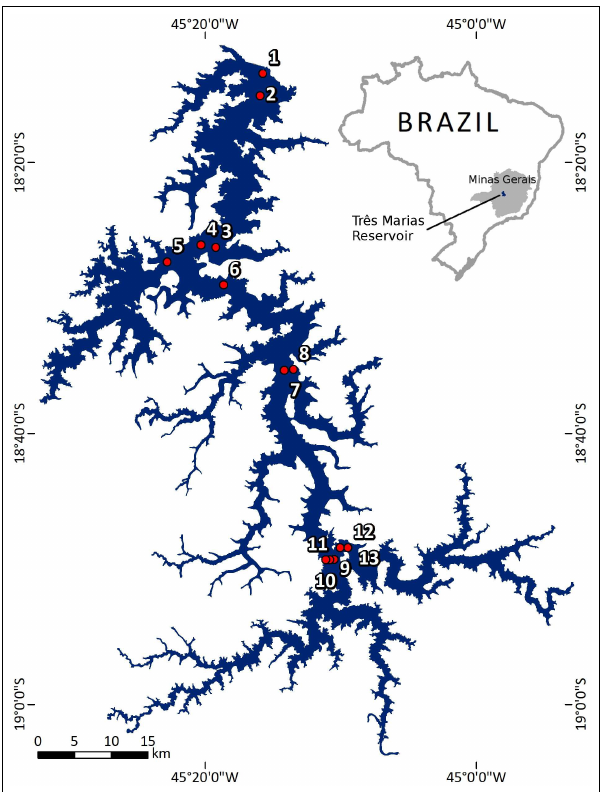
Figure 1. Trˆes Marias Reservoir with the location of the 13 sampling